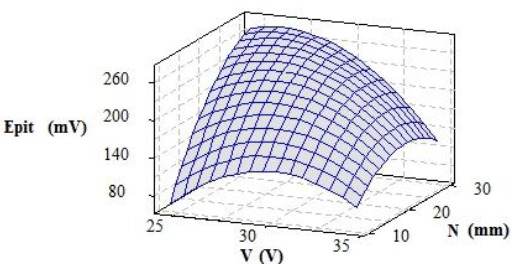
Figure 7. Response surface for interaction effect of welding voltage ( V ) and nozzle to plate distance ( N ) on pitting potential ( E ( W = 8.5 m/min; S = 40.0 cm/min).